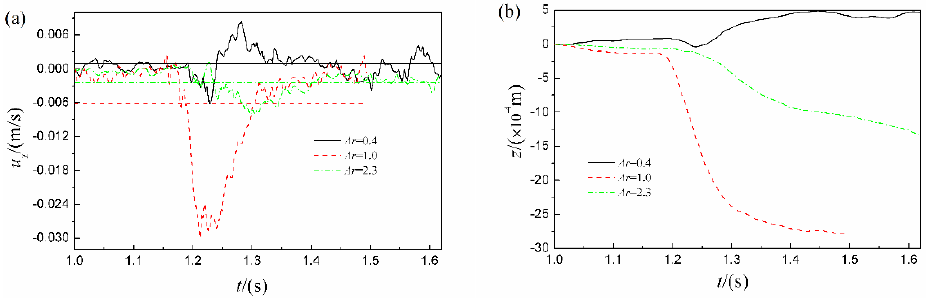
Figure 15. Effects of Ar on particle sedimentation velocity ( a ) and displacement ( b ).